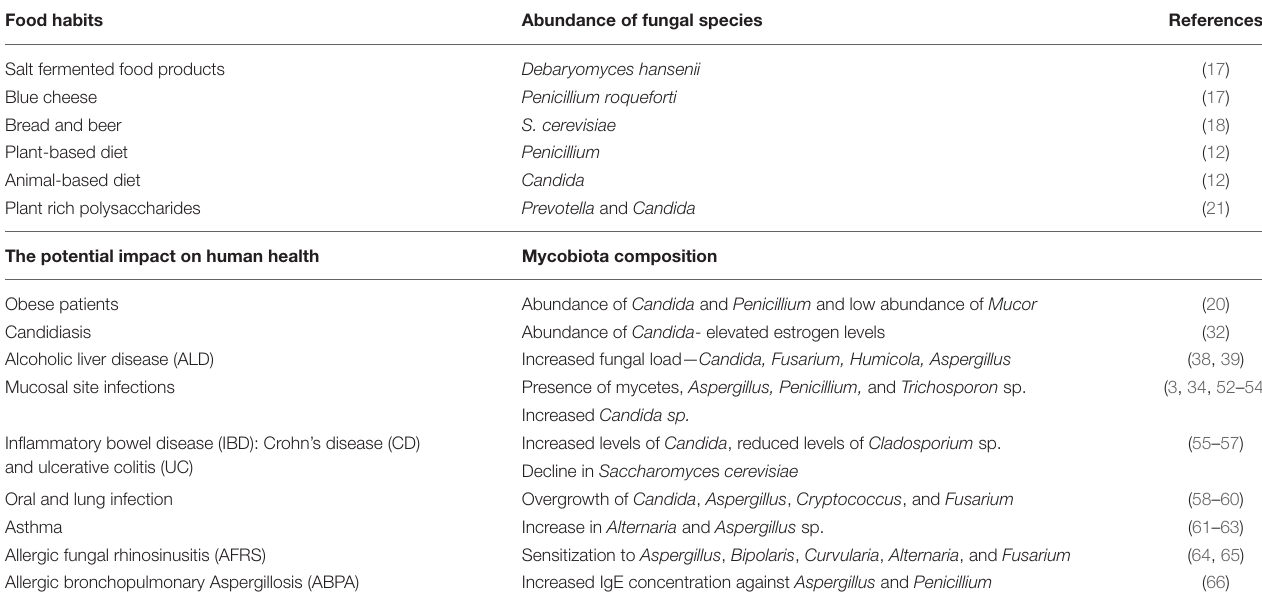
TABLE 1 | Impact on human health due to the alteration in mycobiota